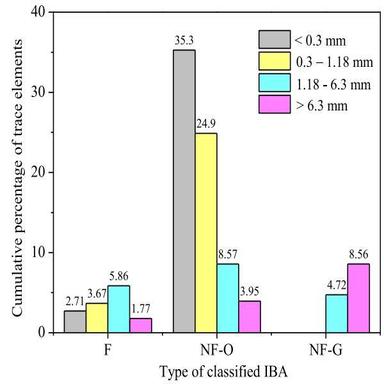
Distribution of total emission of trace elements in classified IBA.